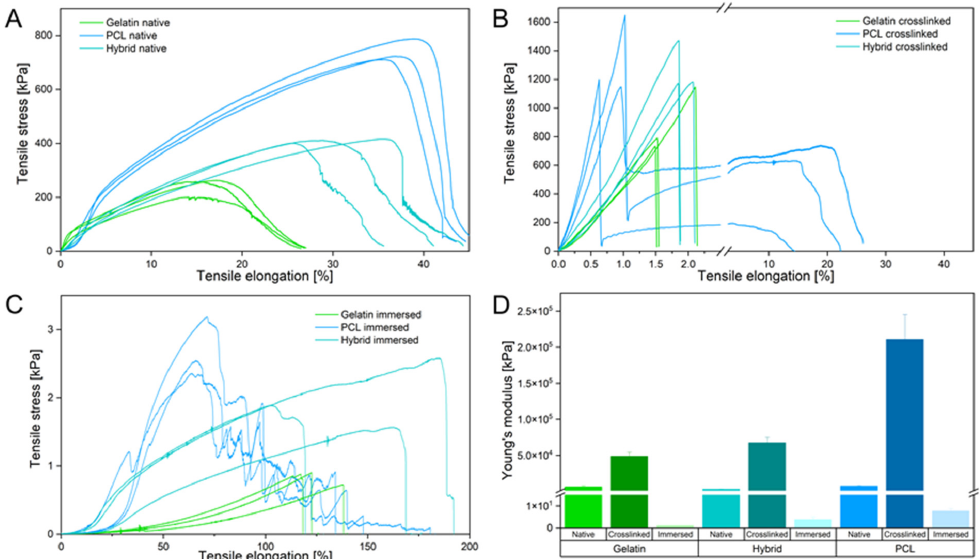
Figure 6. ( A – C ) Stress–strain curves of the native ( A ), crosslinked ( B ), and immersed ( C ) electrospun scaffolds. ( D ) Young’s modulus of native, crosslinked, and immersed electrospun